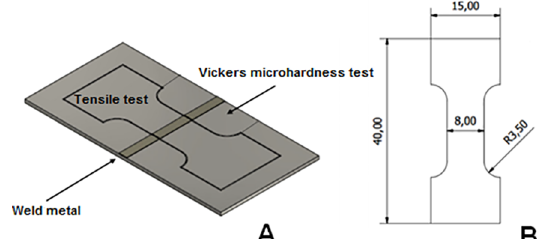
Figure 4. Schematic representation of (a) tensile test and microhardness test samples (b) tensile test sample dimensions, in mm.